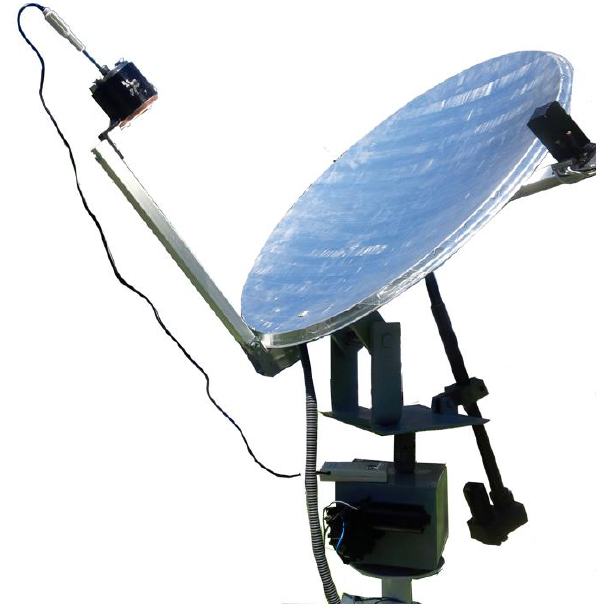
Figure 17. Solar dish concentrator